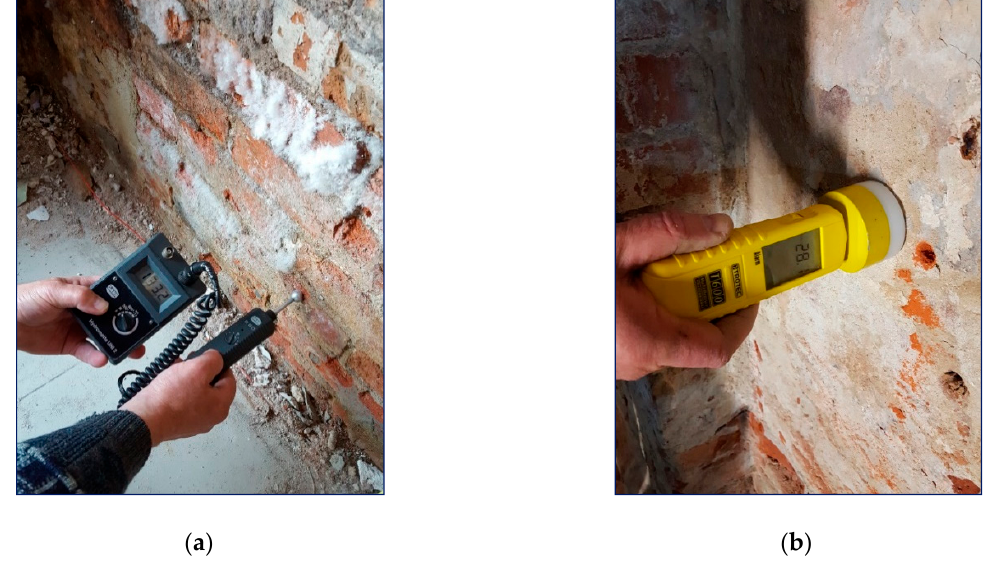
Figure 10. Validation of humidity tests carried out with the use of: ( a ) the dielectric method; ( b ) microwave method